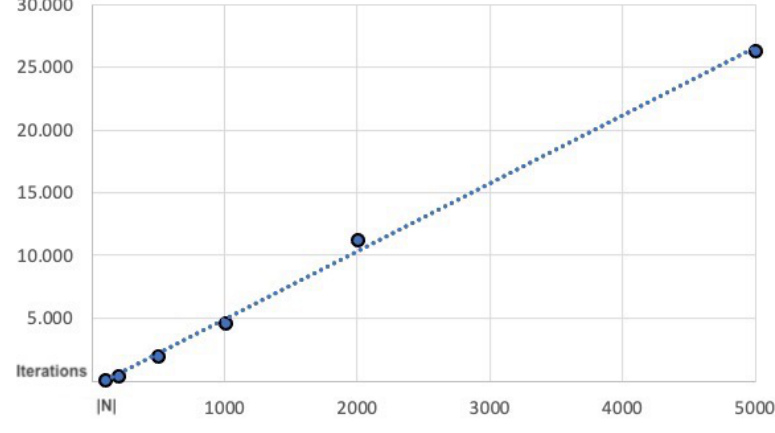
Figure 5. Relationship between the number of IPa iterations and | N | . Table 5. CPU time (milliseconds) of the proposed CH −